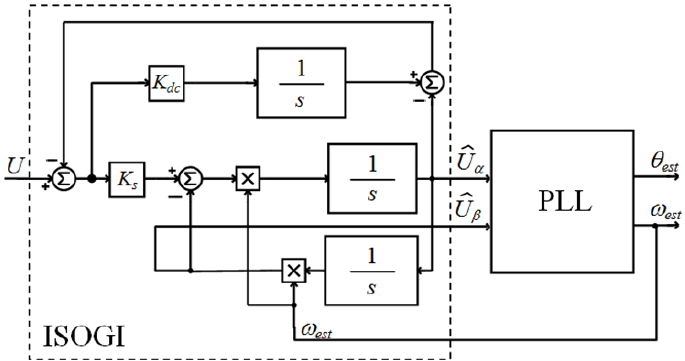
Figure 6. The PLL with the ISOGI orthogonal signal generator.